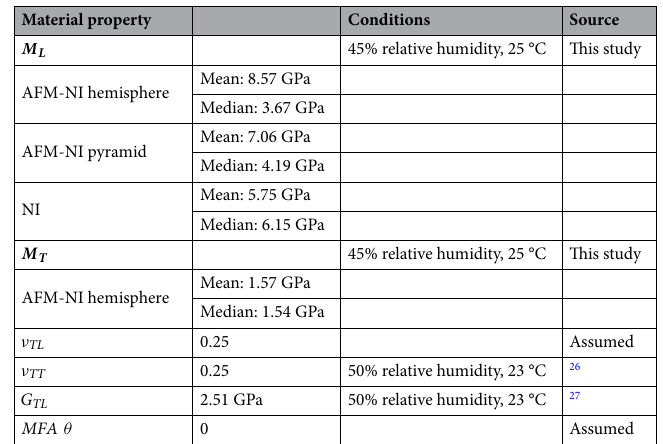
Table 2. Inputs for the determination of the unknown parameters E L and E T based on measurements with AFM-NI and NI and literature data obtained from the same type of